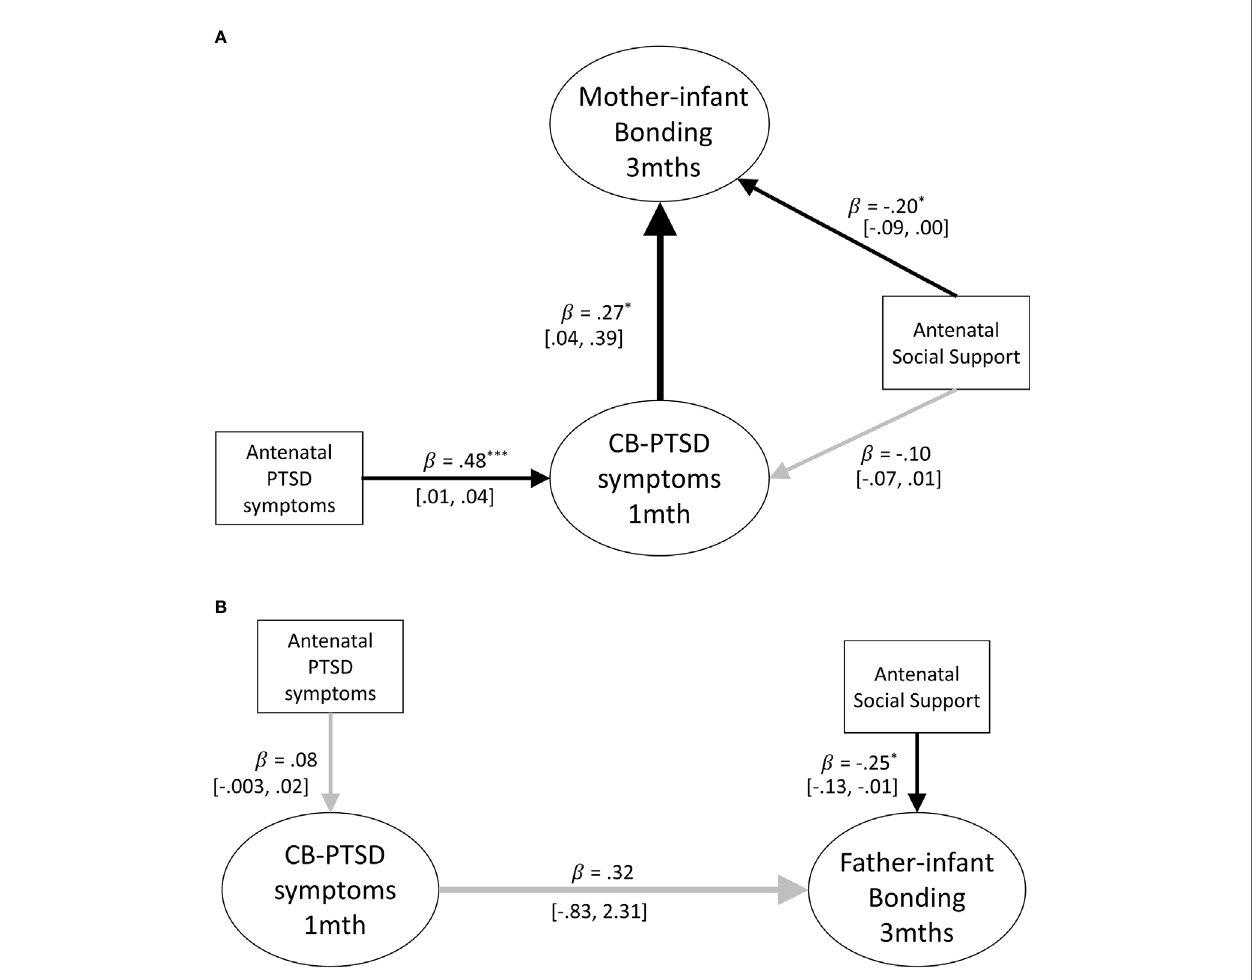
FIGURE 2 | (A) Path model of the prospective prediction of mother-infant bonding at 3 months by postpartum PTSD symptoms at 1 month. Antenatal social support and PTSD symptoms are covariates. Black lines indicate signi fi cant pathways, grey lines indicate non-signi fi cant pathways. Standardized coef fi cients are reported and 95% con fi dence intervals. p < .05; **p < .01; ***p < .001. (B) Path model of the prospective prediction of father-infant bonding at 3 months by postpartum PTSD symptoms at 1 month. Antenatal social support and PTSD symptoms are included as covariates. Black lines indicate signi fi cant pathways, grey lines indicate non-signi fi cant pathways. Standardized coef fi cients and 95% con fi dence intervals are reported. PTSD-CB, childbirth-related posttraumatic stress. *p < .05; **p < .01; ***p <